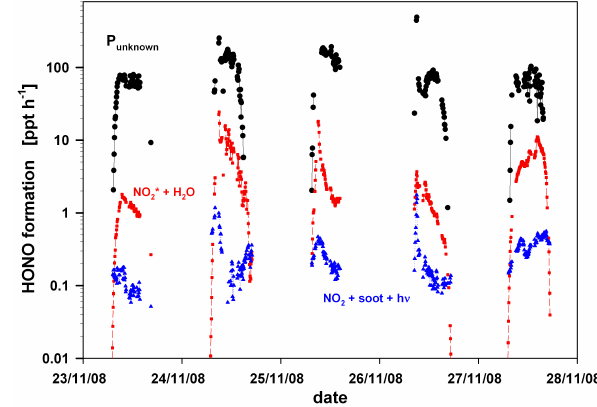
Fig. 5. Diurnal cycle (only daytime) of the unknown HONO source ( P unknown ) , normalized by NO 2 mixing ratios from 7 cloud-free days (same as Fig. 2). To reflect more stationary conditions, only values where 1 HONO/ 1t was lower than the relative error of the LOPAP were included in this graph. The upper ends of the bars re- flect the 75th percentiles, the lower bounds the 25th percentiles and the line in between the medians. The upper whiskers represents the 90th percentiles and the lower the 10th percentiles. The minimum number of data points per hour is 17 (07:00), the maximum is 59 (13:00), except for the values close to sunset (17:00) with only 8 data points. Orange dots and bars represent the mean and standard deviation of j (NO 2 ) for these days, respectively. The insert shows the same data, but as correlation plot of normalized P unknown versus j (NO 2 ) . The r 2 of the regression line is 0.47.